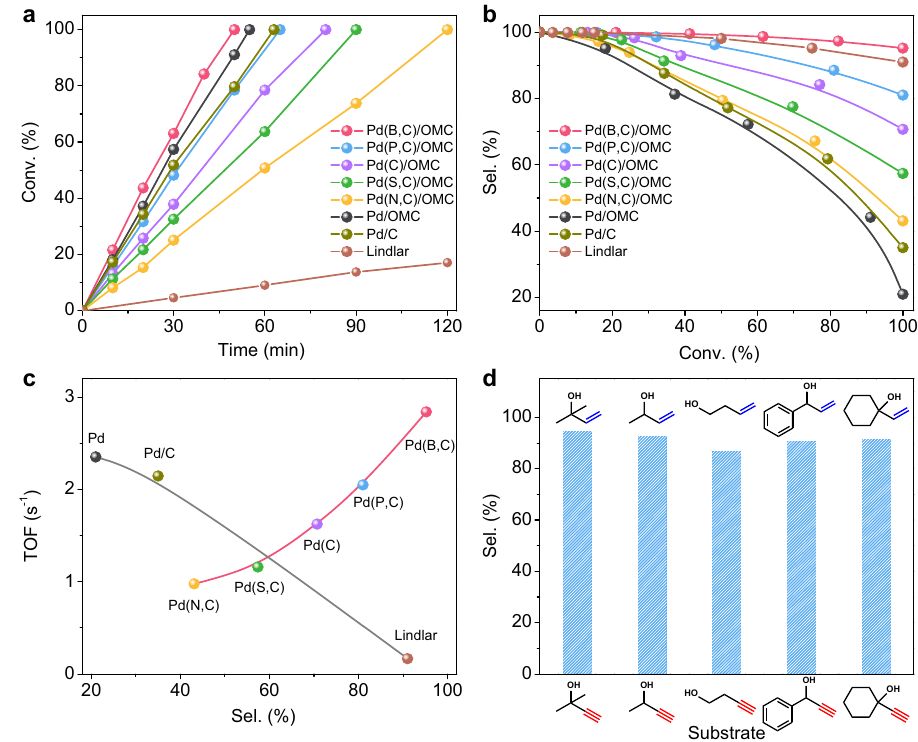
Fig. 3 Kinetics. a MBY conversion (Conv.) as a function of time, b compile of the selectivity (Sel.) to MBE as a function of MBY conversion, and c relationship between the TOF values and selectivity of MBE on the studied Pd nanocatalysts. d Semi-hydrogenation of various alkynols on Pd(B,C)/OMC. The reaction conditions were: 0.045 mol% Pd; 1.25 mmol of the substrate; 5 mL of ethanol; 25 °C; 800 rpm; and in the presence of hydrogen by an H 2 balloon under atmospheric